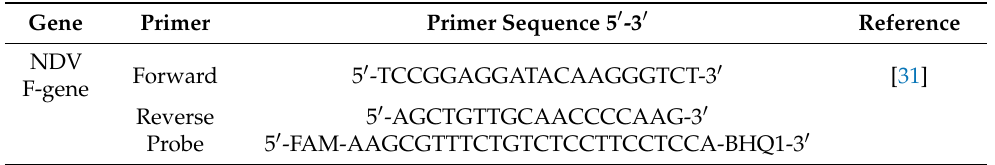
Table 1. Oligonucleotide primers used for the amplification of the NDV